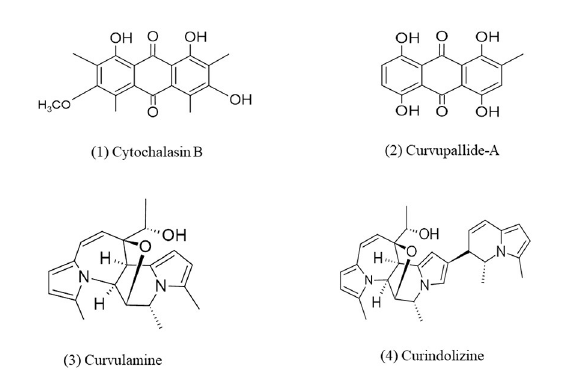
FIGURE4 Chemical structures of bioactive compounds of alkaloid family of Curvularia spp. (1) Cytochalasin B, (2) Curvupallide-A, (3) Curvulamine, and (4)